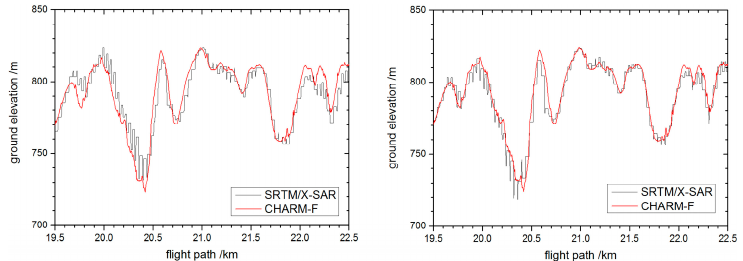
Figure 3. Zoom into the ground elevations along a CHARM-F flight path in Central Italy. Left panel: Direct comparison of the measured lidar elevation data with SRTM elevation data (assumed ground spot trace). Right panel: After the correction of the lidar’s pointing angles, showing the SRTM data for a corrected, i.e., slightly shifted, lidar ground spot trace.